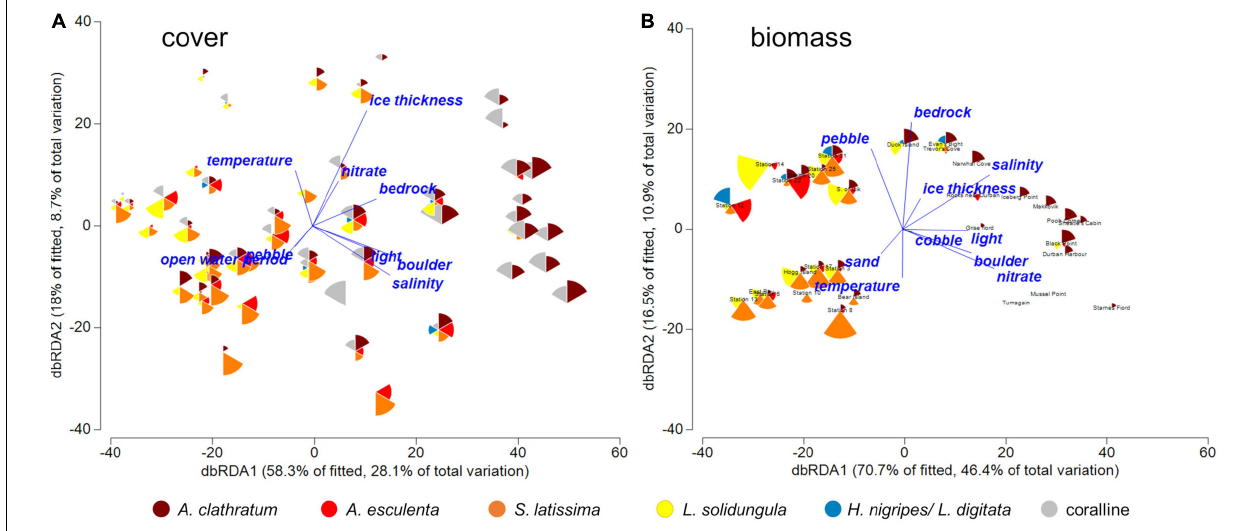
FIGURE 4 | Seaweed assemblage relationship with abiotic variables across the Eastern Canadian Arctic. Data are presented for cover (A) and biomass (B) , pooled over 5, 10, and 15 m depths. Points are based on dbRDA using Bray Curtis dissimilarity matrix of square-root transformed data. Vectors (blue) show correlations between ordinations for macroalgal assemblages and average environmental conditions and substrata at each site. Color and size of the pie sections shows the relative abundance of the five most dominant kelp species. The size of each piece indicates the percent cover and biomass of different species, from 0 to 100% or 0 to 10 kg m – 2 . Note “sand” substrata is not shown for clarity in (A) because it occurs directly under “open water period.” For site key see Supplementary Table 1 .